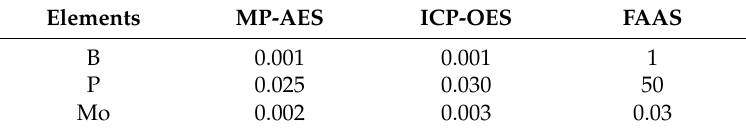
Table 7. Comparison of limit of detection (LOD) in mg/L of different techniques.